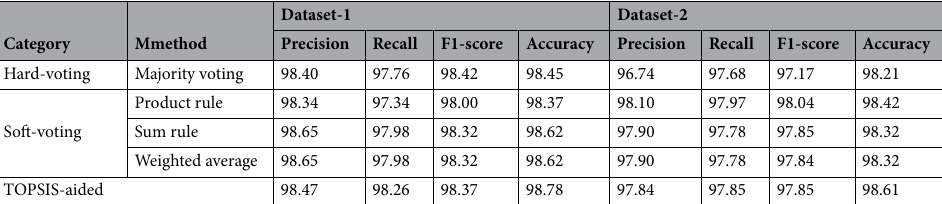
Table 4. Performance comparison of the TOPSIS aided ensemble method with other popular ensemble methods. All the scores reported are in